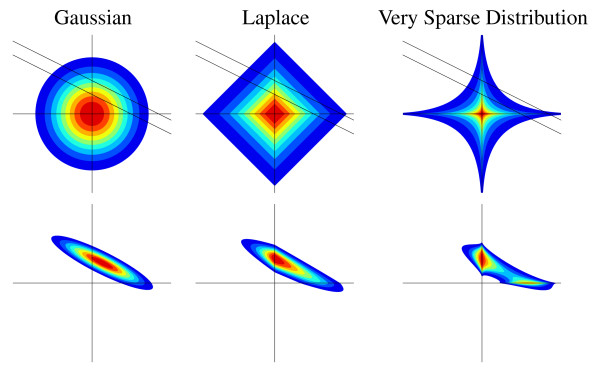
The Choice of Model. Three prior distribution candidates over network matrix coefficients: Gaussian, Laplace, and "very sparse" distribution (P(aij) ∝ exp(- τ|aij|0.4)). We show contour plots of density functions over two entries, coloured areas contain the same probability mass for each of the distributions. Upper row: prior distributions (unit variance), and likelihood for single measurement (linear constraint with Gaussian uncertainty). Lower row: corresponding posterior distributions. The Gaussian is spherically distributed, the others shift probability mass towards the axes, giving more mass to sparse tuples (≥ 1 entry close to 0). This effect is clearly visible in the posterior distributions. For the Gaussian prior, the area close to the axes has rather low mass. The Laplace-posterior is skewed: more mass is concentrated close to the vertical axis. Both posteriors are log-concave (and unimodal). The "very sparse"-posterior is shrunk towards the axes more strongly, sparsity is enforced stronger than for the Laplace prior. But it is bimodal, giving two different interpretations for the single observation. This multimodality increases exponentially with the number of dimensions, rendering accurate inference very difficult. The Laplace prior therefore is a good compromise between computational tractability and suitability of the model.